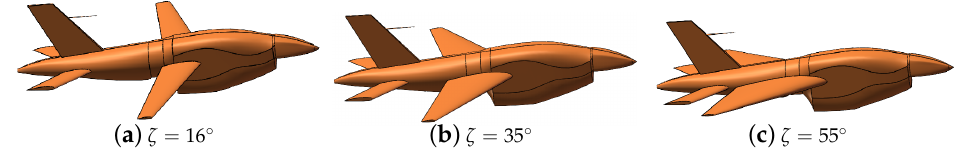
Figure 2. The configurations of the Firebee